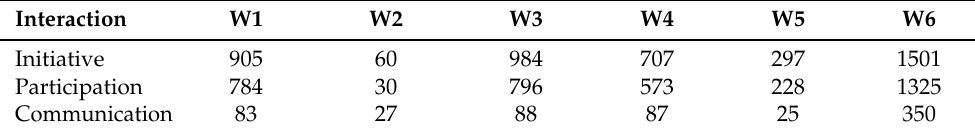
Table 4. Total number of interactions (per week).